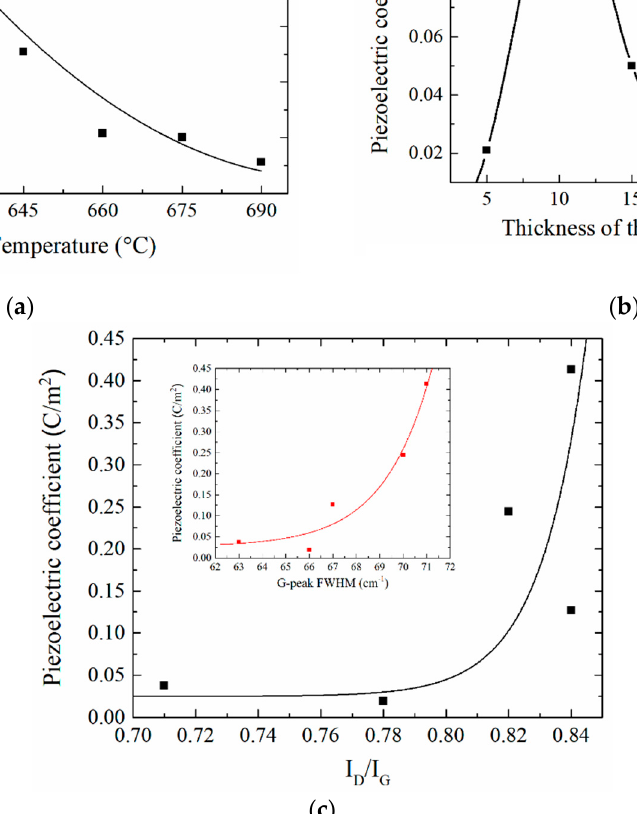
Figure 7. ( a ) Dependences of the effective piezoelectric coefficient of CNTs on the growth temperature at a catalytic Ni layer of 15 nm, ( b ) on the thickness of the catalytic Ni layer at a temperature of 675 °C and ( c ) on the defectiveness of CNTs. The inset in Figure 5c shows the dependence of the piezoelectric coefficient of CNTs on the full width at half maximum of the G-peak of the CNT spectra, reflecting the change in the curvature of the surface of the graphene sheet forming the CNT.